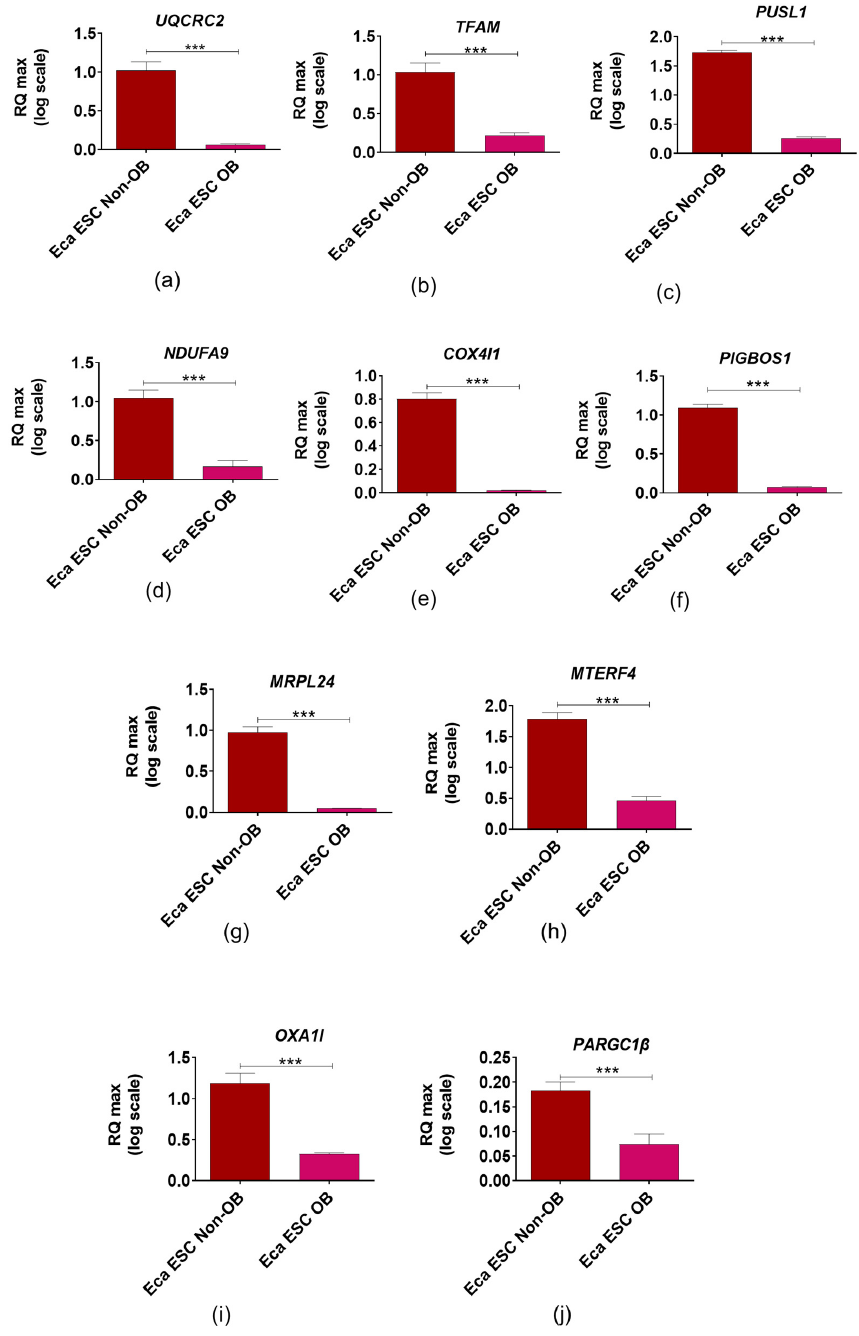
Figure 8. Transcript levels for genes associated with mitochondria homeostasis determined for equine endometrial progenitor cells (Eca EPCs) isolated from non-obese mares (non-OB) and obese mares (OB). The analysis was performed usi, bng RT-qPCR technologies. The following genes were measured: ubiquinol-cytochrome c reductase core protein 2 (UQCRC2, ( a )), transcription factor A, mitochondrial (TFAM, ( b )), pseudouridylate synthase-like 1 (PUSL1, ( c )), NADH: ubiquinone oxidoreductase subunit A9 (NDUFA9, ( d )), cytochrome c oxidase subunit 4I1 (COX4I1, ( e )), PIGB opposite strand 1 (PIGBOS1, ( f )), mitochondrial ribosomal protein L24 (MRPL24, ( g )), mitochondrial transcription termination factor 4 (MTERF4, ( h )), mitochondrial inner membrane protein (OXA1L, ( i )) and PPARG coactivator 1 beta (PPARGC1 β , ( j )). Obtained data were normalized to the expression of the reference gene and expressed as using RQ (max) algorithm. Results are presented as columns with bars representing means ± SD. *** p -value <